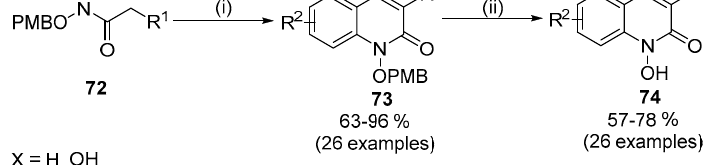
reaction of protected N -hydroxyamides 72 with benzaldehydes or benzoates followed by cyclodehydration and deprotection [42].